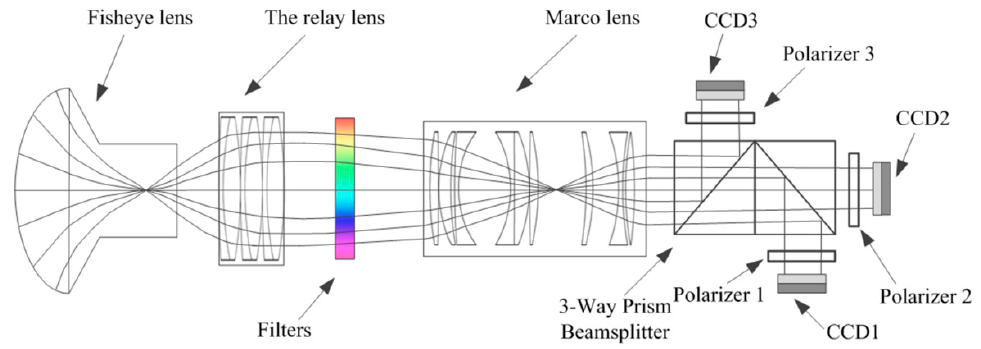
Figure 1. The full-sky skylight polarization pattern imaging system.